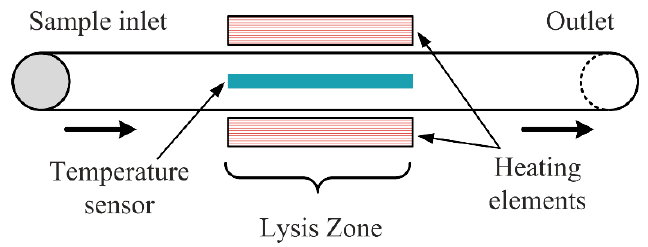
Figure 24. Thermal lysis in a microfluidic